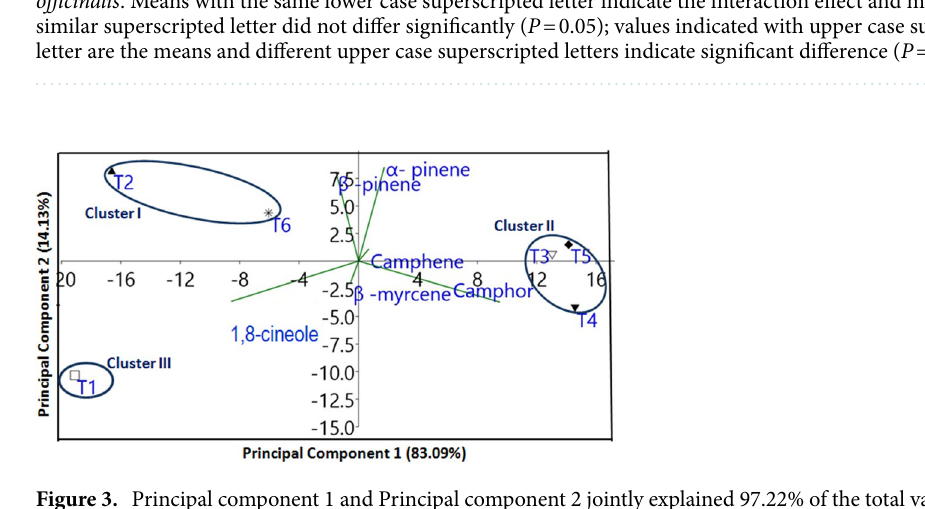
Figure 3. Principal component 1 and Principal component 2 jointly explained 97.22% of the total variation for T1, T2, T3, T4, T5 and T6 where T1: Rainy season IHBT/RMAc-1; T2: Rainy season IHBT/RMAc-2; T3: Autumn season IHBT/RMAc-1; T4: Autumn season IHBT/RMAc-2; T5: Summer season IHBT/RMAc-1; T6: Summer season